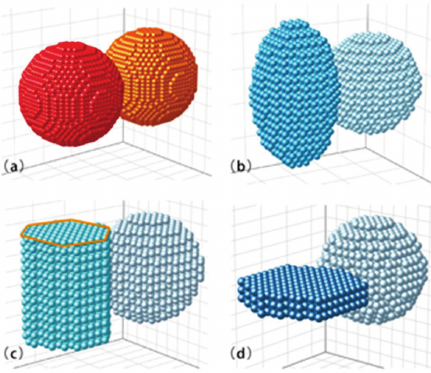
Figure 2. Ice crystal particle model with agglomerated structure. ( a ) sphere–sphere; ( b ) sphere– ellipsoid; ( c ) sphere-hexagonal prism; ( d ) sphere-hexagonal